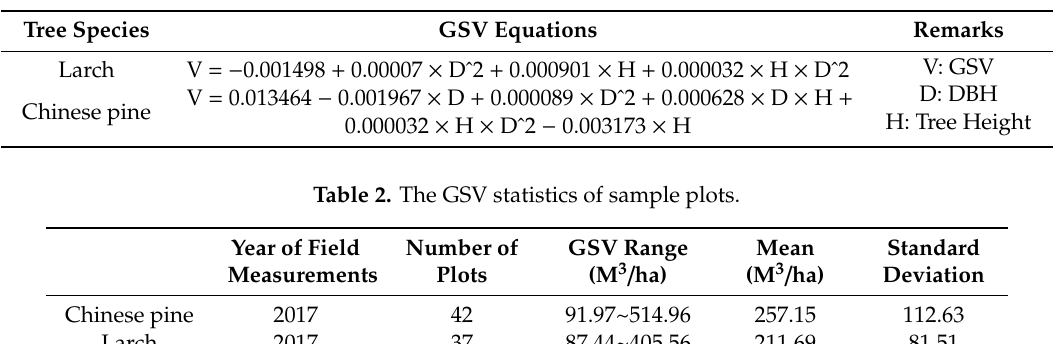
Table 1. Tree GSV equations of Chinese pine and larch.